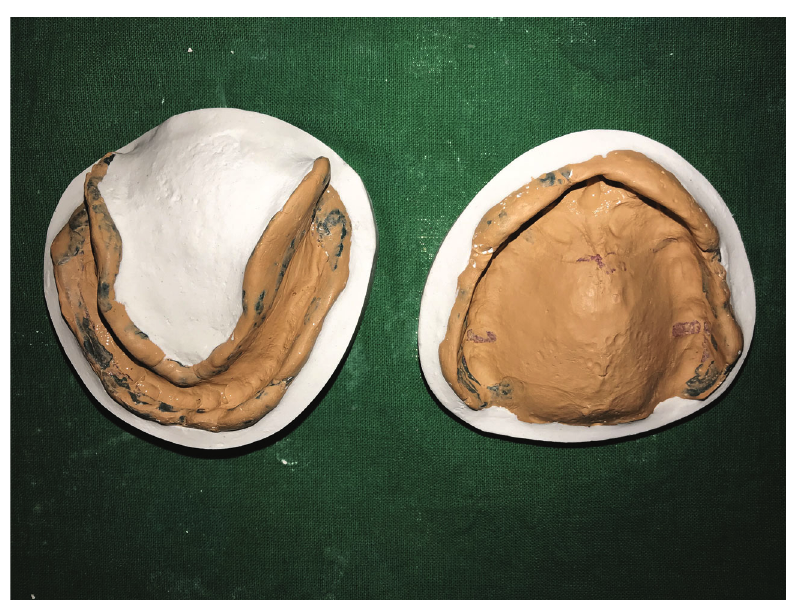
Figure 2: Secondary